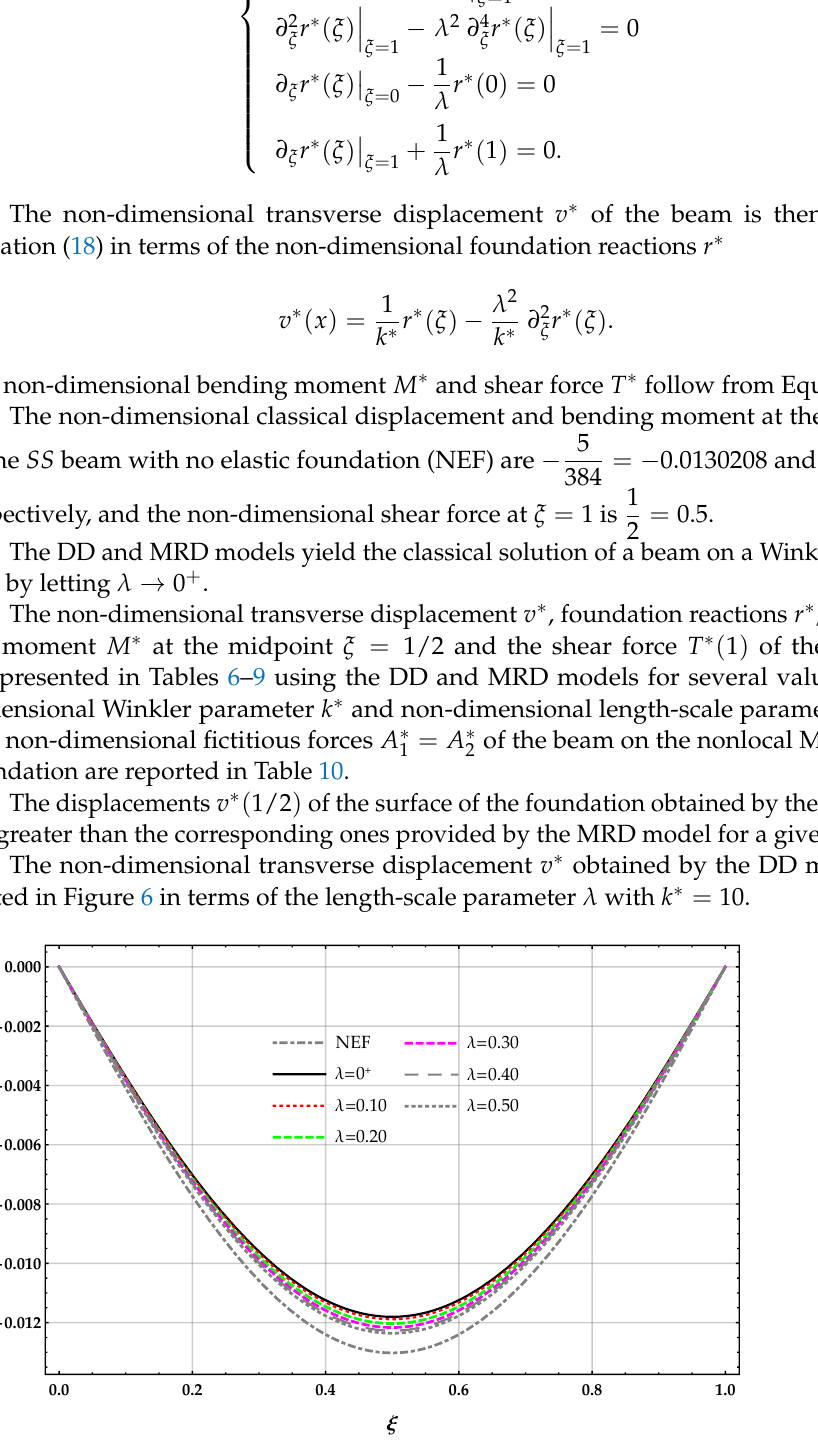
Figure 6. SS − q beam. DD method: plots of the non-dimensional transverse displacement v ∗ of the surface of the elastic foundation for increasing values of the non-dimensional non-local parameter λ (cid:8) (cid:9) in the set 0 + ,0.1,0.2,0.3,0.4,0.5 with k ∗ =